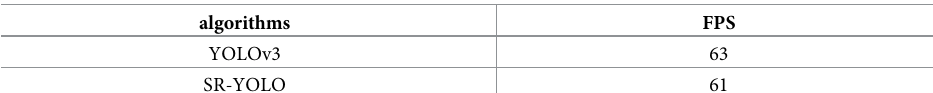
Table 8. Frames per second test